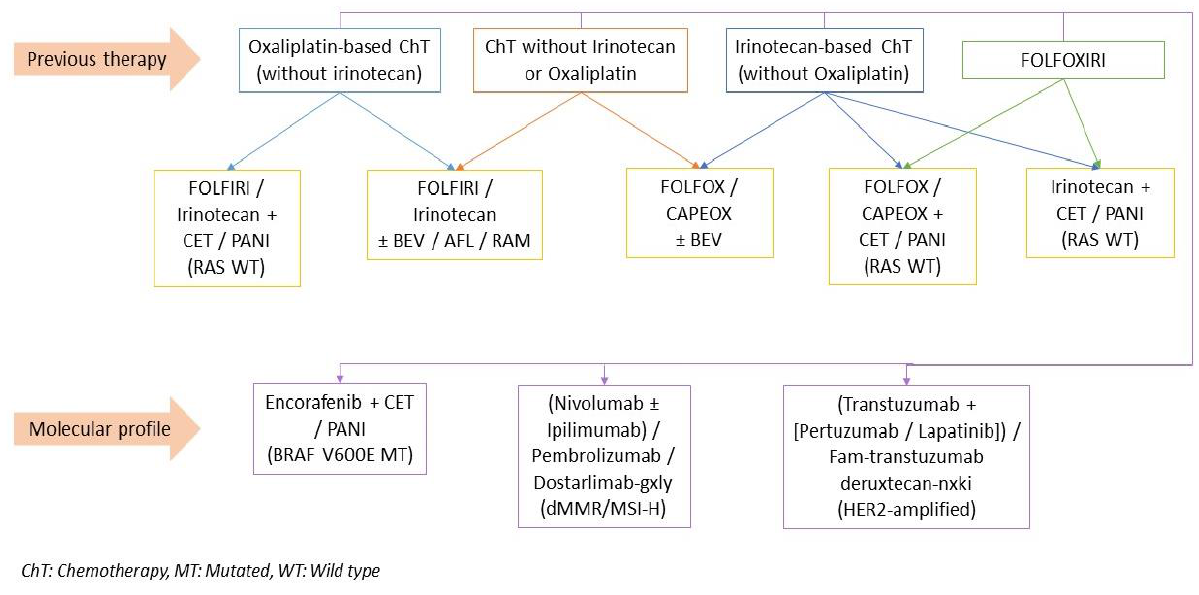
Figure 6. Second-line Systemic Treatment for Stage IV CRC. After progression on second-line therapy, patients with RAS/BRAF wild-type disease should receive an EGFR inhibitor combined with irinotecan. Alternatively, if they have HER2 mutation, transtuzumab can be preferred. If patients have BRAF V600E mutation, the encorafenib-cetuximab regimen should be considered [20,22]. Patients with RAS mu- tation who progressed under second-line therapy are considered to have the refractory disease [16]. Treatment with regorafenib or trifluridine and tipiracil is recommended for patients with refractory disease [16,20,22] as they may provide survival benefits compared to placebo [177,178]. 5. Surveillance The goal of surveillance in mCRC is to identify potentially resectable mCRC recur- rences or new metachronous mCRC lesions. Surveillance protocols generally include fol- low-up visits with a clinical exam, tumor markers, imaging, and endoscopy. Generally, these follow-up visits occur up to 5 years after treatment, with more frequent surveillance in the first 2 – 3 years. This surveillance period is supported by evidence showing that 80 –